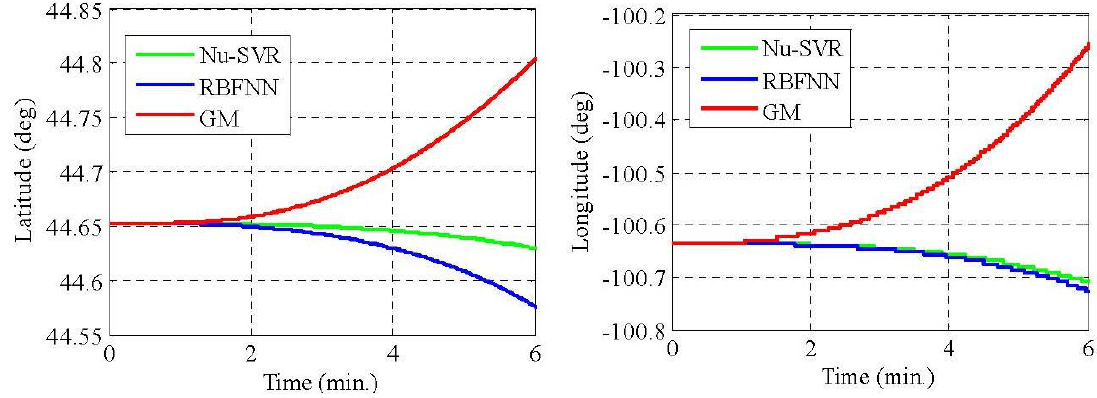
Figure 9. Position drifts by GM, RBFNN and Nu-SVR methods.